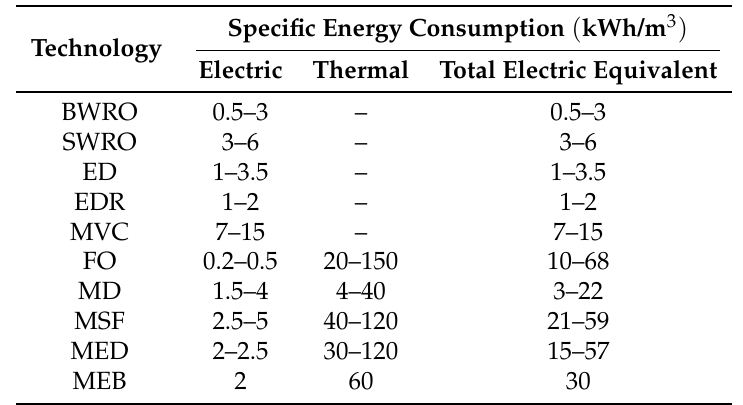
Table 1. Specific energy consumption, as reported in literature [9,16,17,19–28], varies for different desalination technologies. Total equivalent specific energy consumption is equal to the sum of kilowatt-hours (electric) and kilowatt-hours (thermal), converted based on an assumed 45% efficiency of a modern power station [16]: equivalent electric kWh/m 3 = kWh e /m 3 + 0.45 kWh th /m 3